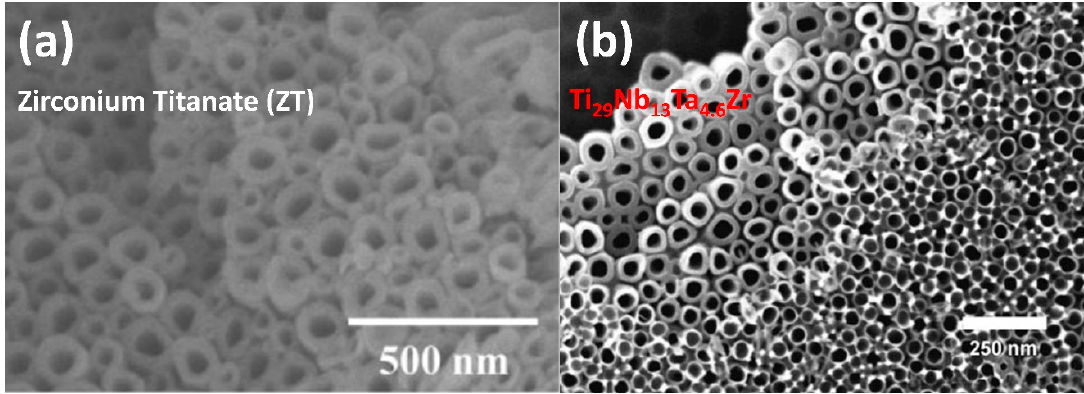
Figure 4. ( a ) SEM image of Ti-Zr alloy arrays with ~90 nm diameter and ~30 nm wall thickness, reproduced with permission from Ref. [76], 2007 Wiley-OCH; ( b ) alloy nanotubes broken off at different height levels from Ref. [79], 2006 Wiley-VCH.